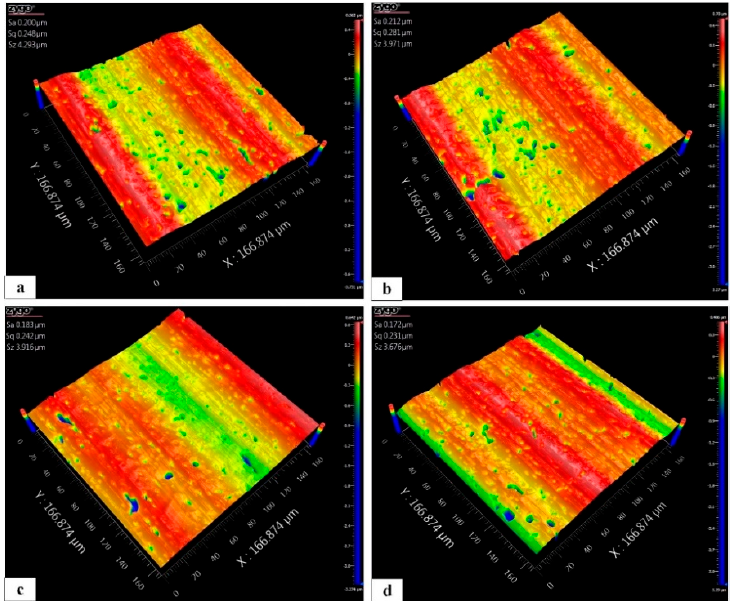
Figure 19. Workpiece surface morphology of four reference points: ( a ) workpiece 1, ( b ) workpiece 2, ( c ) workpiece 3 and ( d ) workpiece 4.